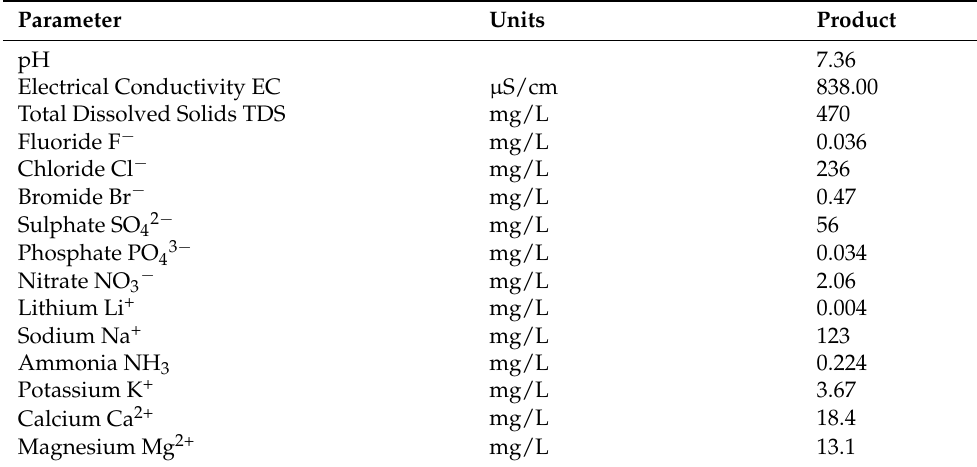
Figure 14. Temperature measured by Thermocouples 1,2 and 3 inside the MSS prototype ‐ 2 (Jun 15th).